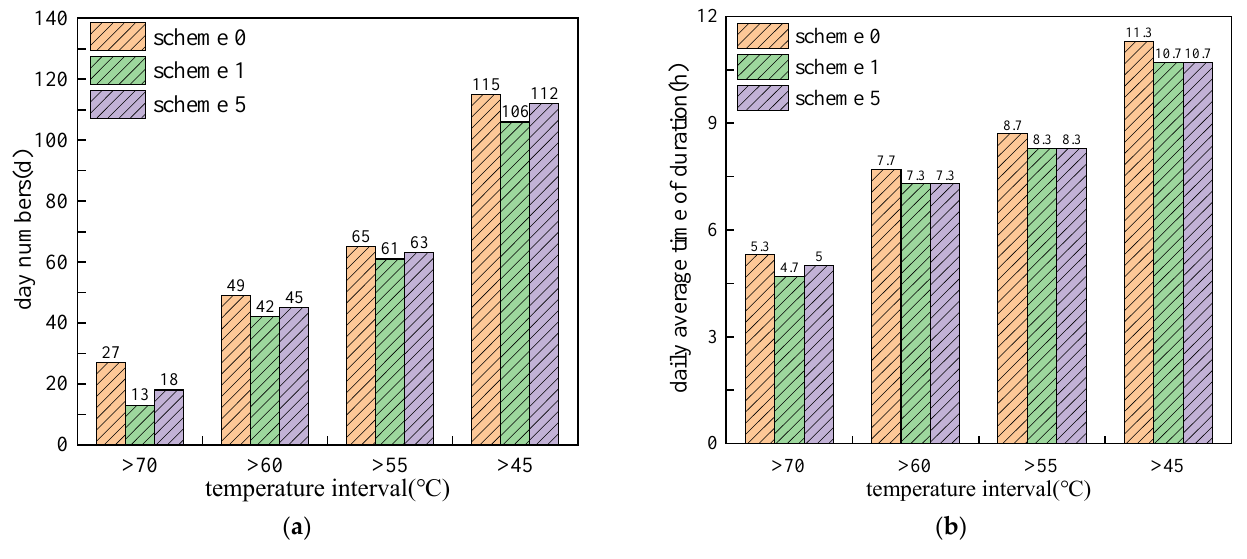
Figure 12. Duration times of daily maximum pavement temperature in different temperature ranges with 5% PCM mixing ratio: ( a ) number of days ; ( b ) daily average duration in hours.